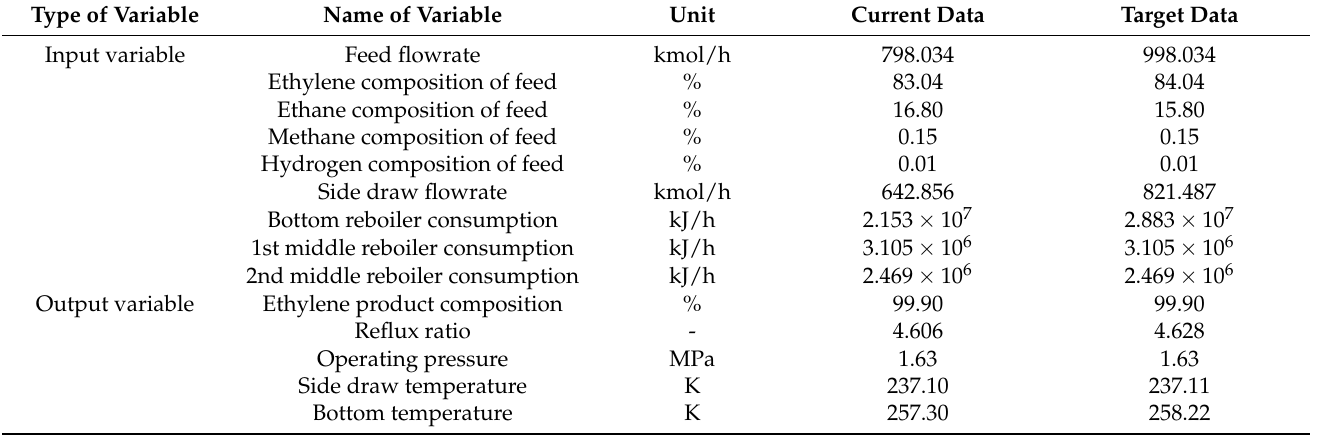
Table 4. Data in diverse working points (new process transition caused by state changes of driv- ing